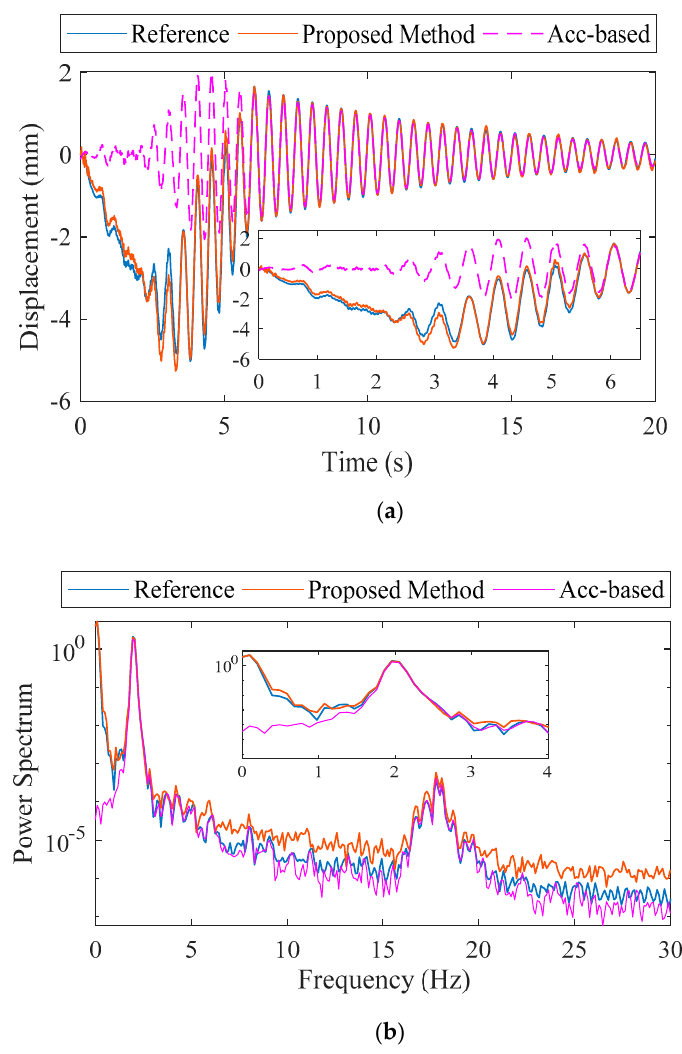
Figure 5. Numerical validation: ( a ) estimated displacement and ( b ) frequency response.